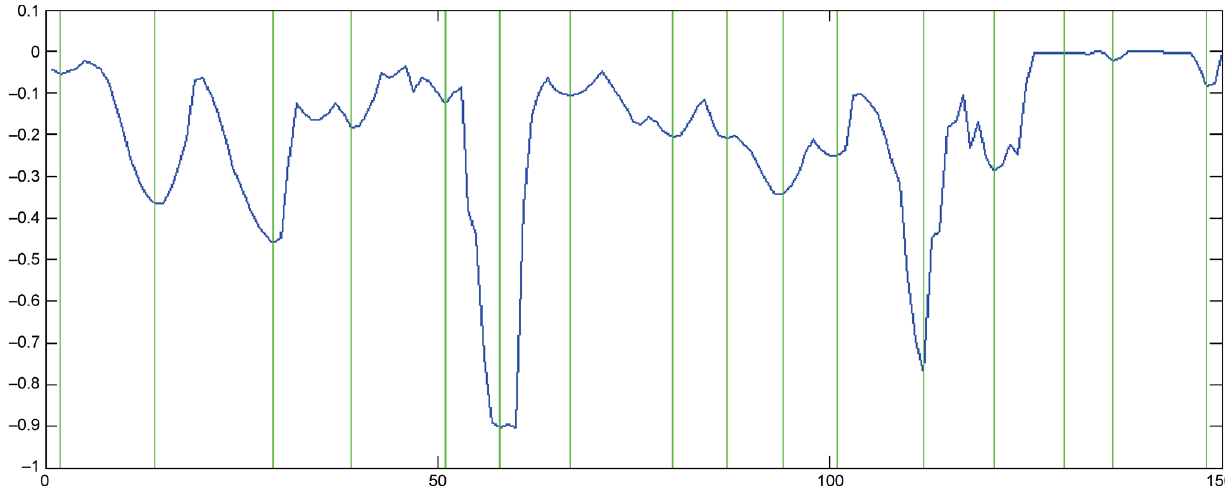
Fig. 4 Frame-level direction-change score for each frame in the video, along with detected local minima of the score (marked by green vertical